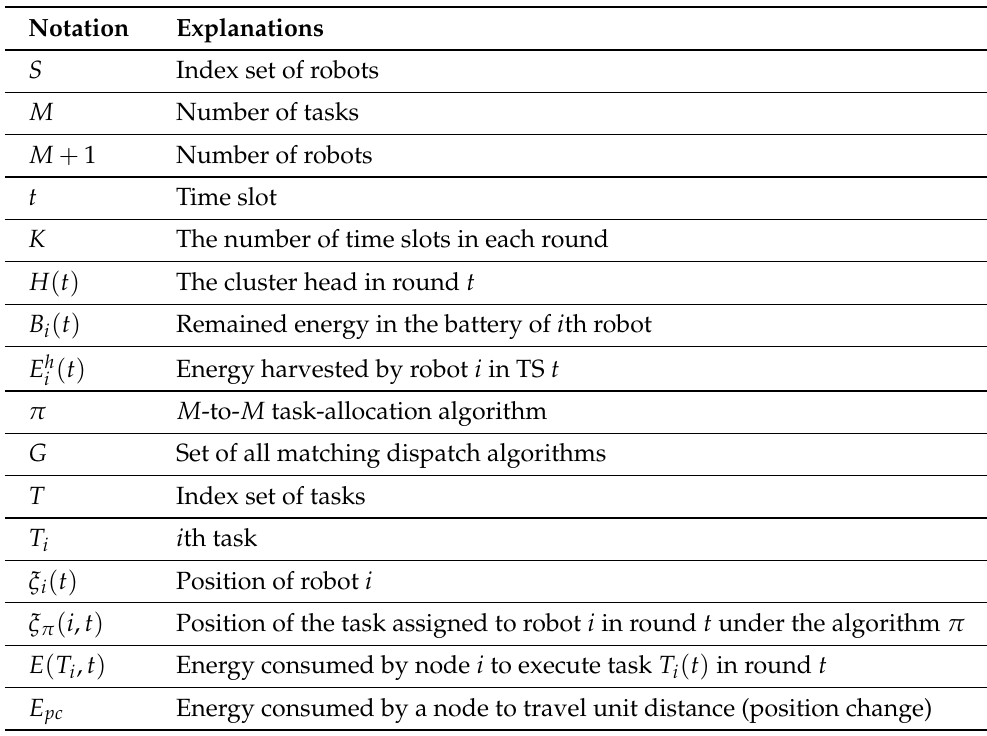
Table 1. Notations and Their